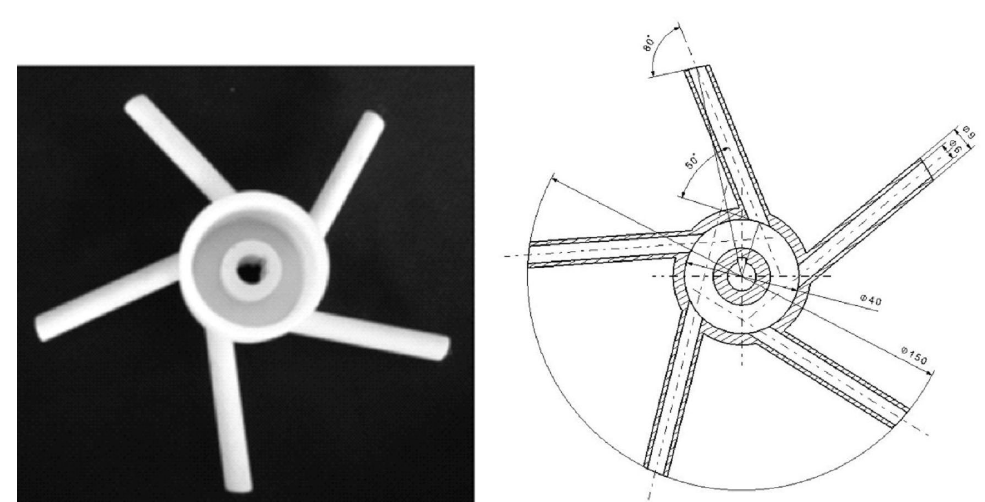
Figure 2: Geometry of the impeller 2 (I2)